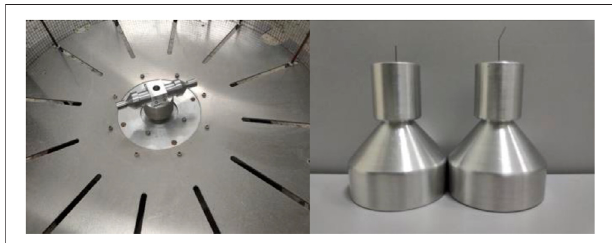
FIGURE 12 | Experimental equipment diagram. (A) The rotating spinning equipment. (B) Curved and straight-tube nozzle.